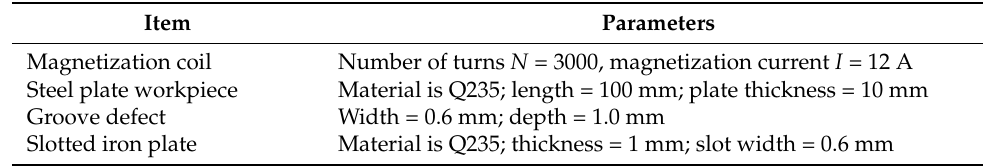
Figure 11. Two-dimensional simulation model of the SFLL-MFL method. Table 2. The parameters of the 2D simulation model.